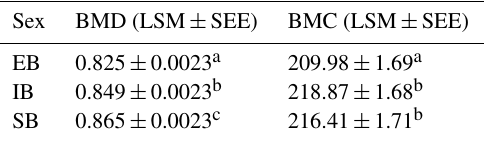
Table 5. BMD (gcm − 2 ) and BMC (g) depending on sex (LSM ± SEE) – average of nine measurements (body regions). Different superscripts represent significant ( p < 0 . 05) differences within column.